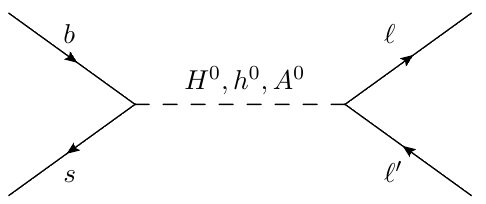
Figure 1 . Tree-level e(cid:11)ects in b ! s‘ + ‘ (cid:0) transitions induced by the (cid:13)avour-changing couplings " d . These diagrams contribute to the Wilson coe(cid:14)cients of scalar operator C ( 0 ) IJ 23 ; 32 eq.